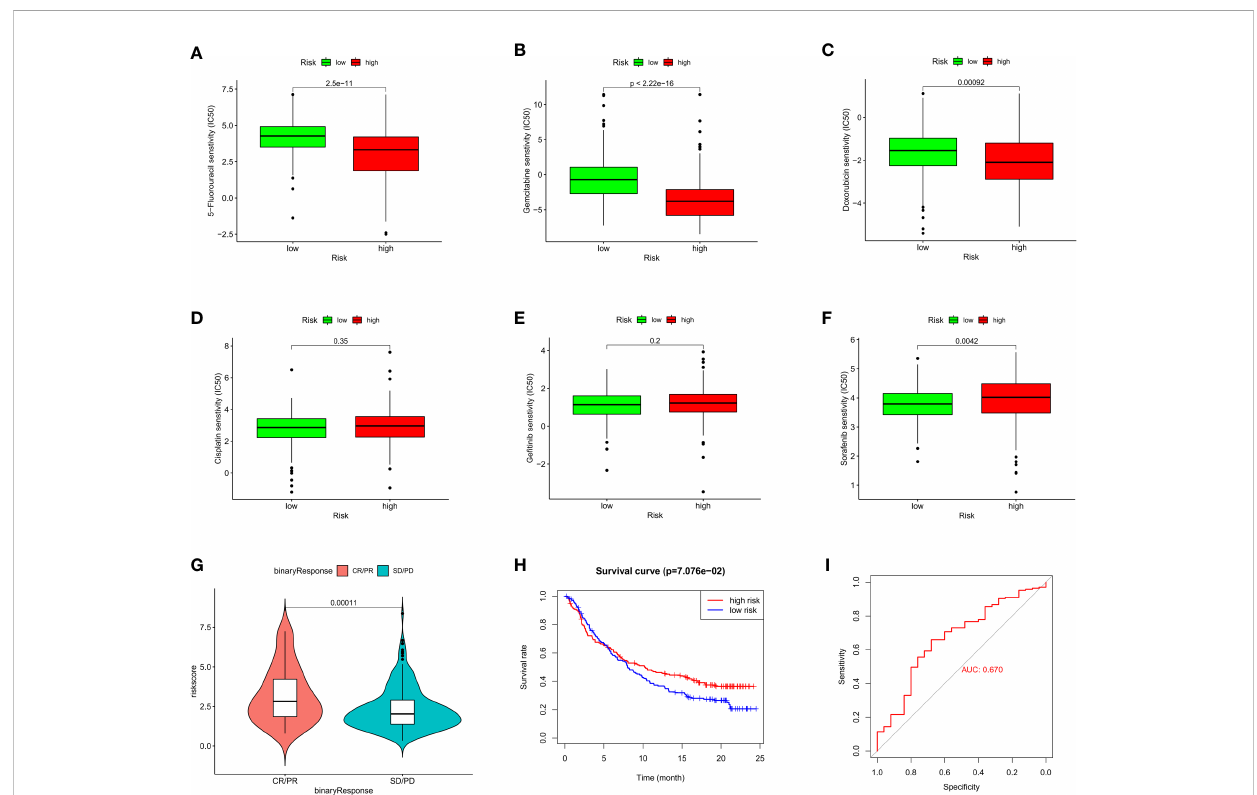
FIGURE 7 Evaluation of chemosensitivity and immunotherapeutic responses to PD-L1 by the risk model. (A – F) Therapeutic ef fi cacy of 5-Fluorouracil (A) , Gemcitabine (B) , Doxorubicin (C) , Cisplatin (D) , Ge fi tinib (E) , and Sorafenib (F) in different risk groups. (G) The comparison of risk score between SD/ PD and CR/PR two groups in IMvigor210 cohort. (H) Kaplan – Meier curves for OS in IMvigor210 cohort. (I) ROC curves of risk score in predicting the immunotherapy